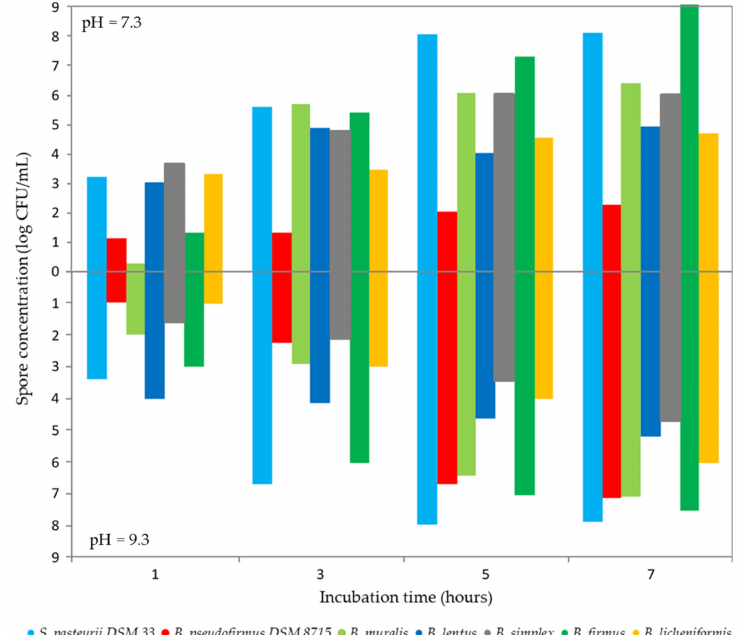
Figure 3. The spore rate in TSB nutrient medium with different pH values.